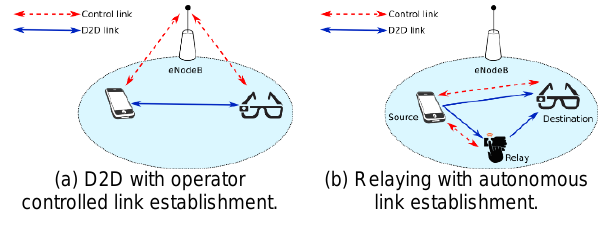
Figure 2. Possible approaches for D2D link